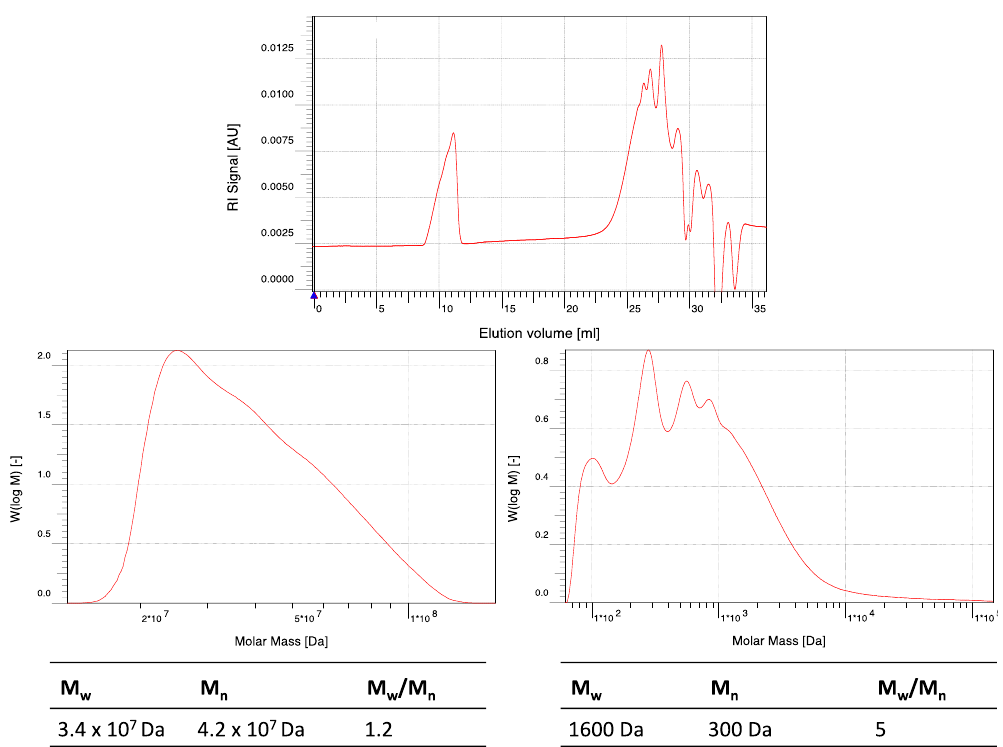
Figure A6. GPC elugram of crude hPES 1 in THF. (Top) full range elugram; y -axis: elution volume. (Bottom) detailed elugrams with molecular weights; y -axis: molar mass.